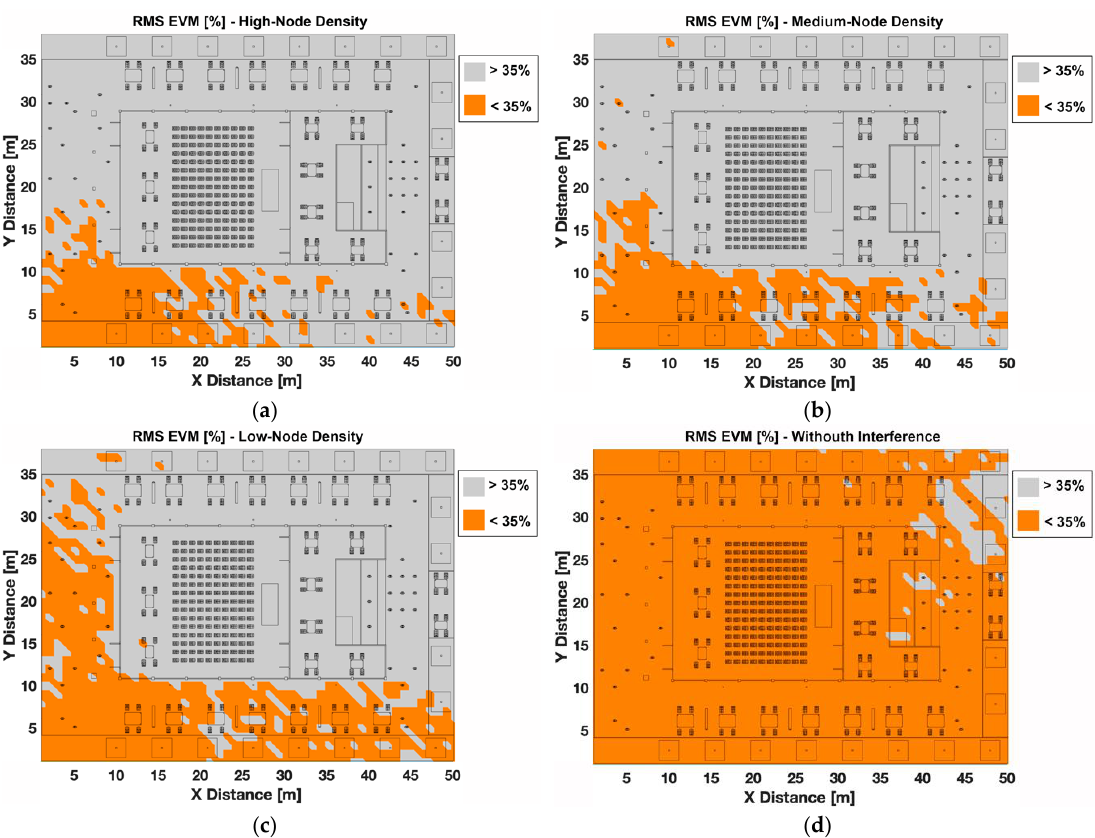
Figure 12. EVM (%) for the considered scenario for O-QPSK modulation when outdoor node is transmitting, ( a ) high-node density scenario, ( b ) medium-node density scenario, ( c ) low-node density scenario, and ( d ) without interference.